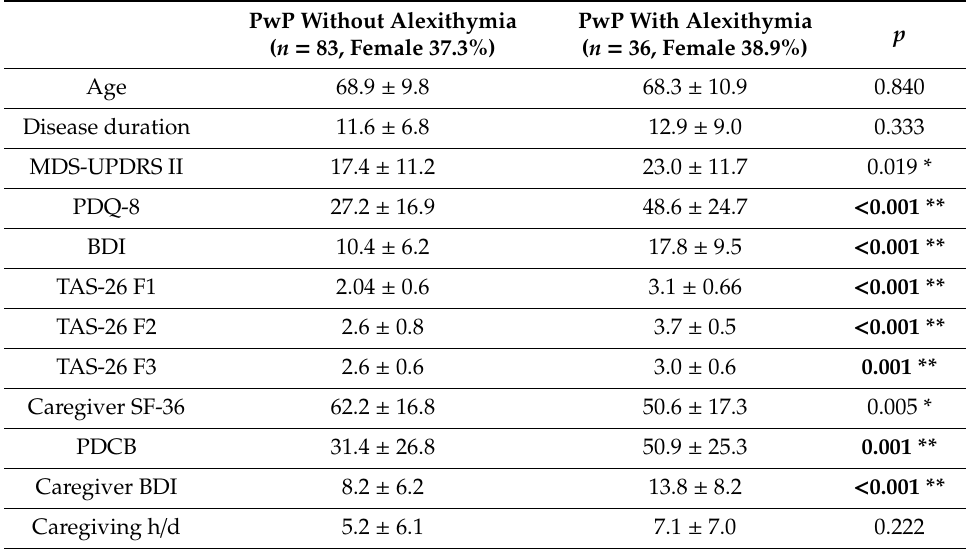
Table 2. Comparison of people with Parkinson’s disease with and without alexithymia. PwP Without Alexithymia ( n = 83, Female 37.3%)